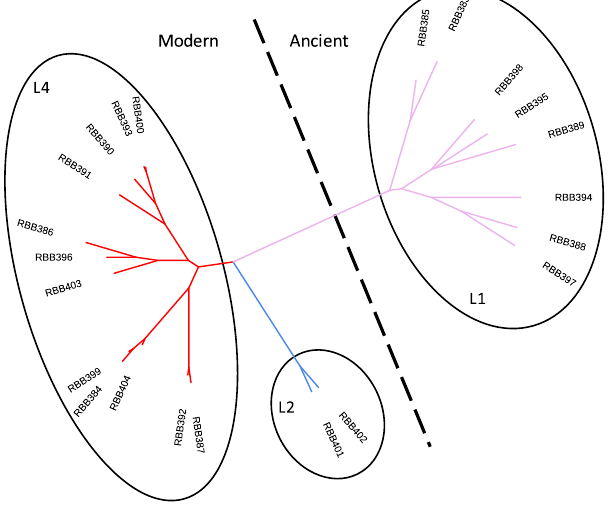
Figure 1. Phylogenetic tree of the 22 Karonga strains. Maximum-likelihood phylogenetic tree of the 22 isolates analysed, covering lineages 1 (L1), 2 (L2) and 4